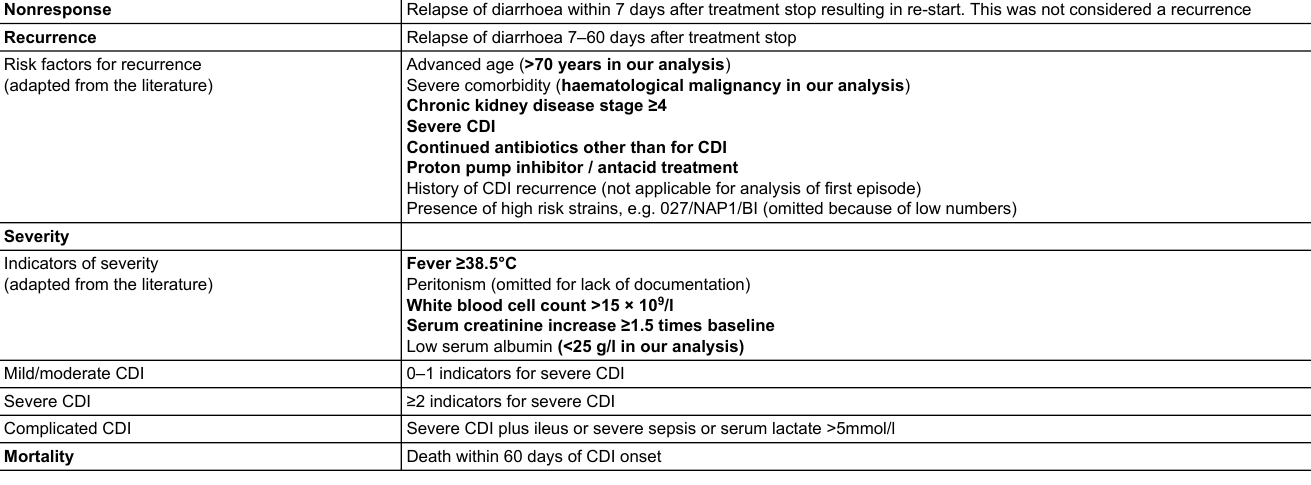
Table 1: Definitions. Risk factors for recurrence and indicators for severe Clostridioides difficile infection (CDI) included in this analysis are shown in bold. Nonresponse